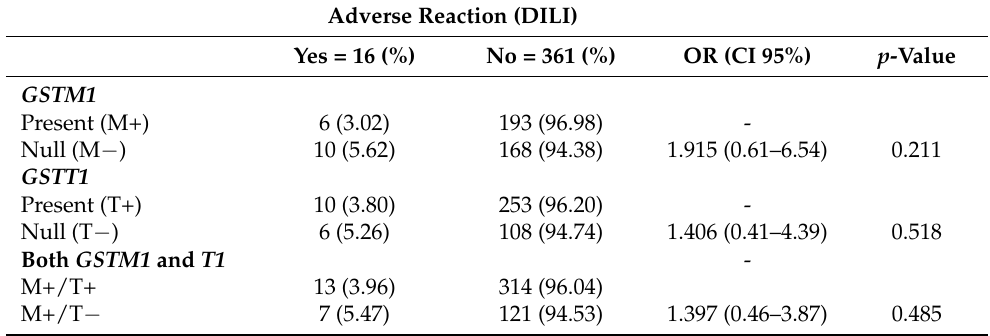
Table 2. Association of the null genotype GSTM1 and T1 with the risk of DILI in the Peruvian population. Adverse Reaction